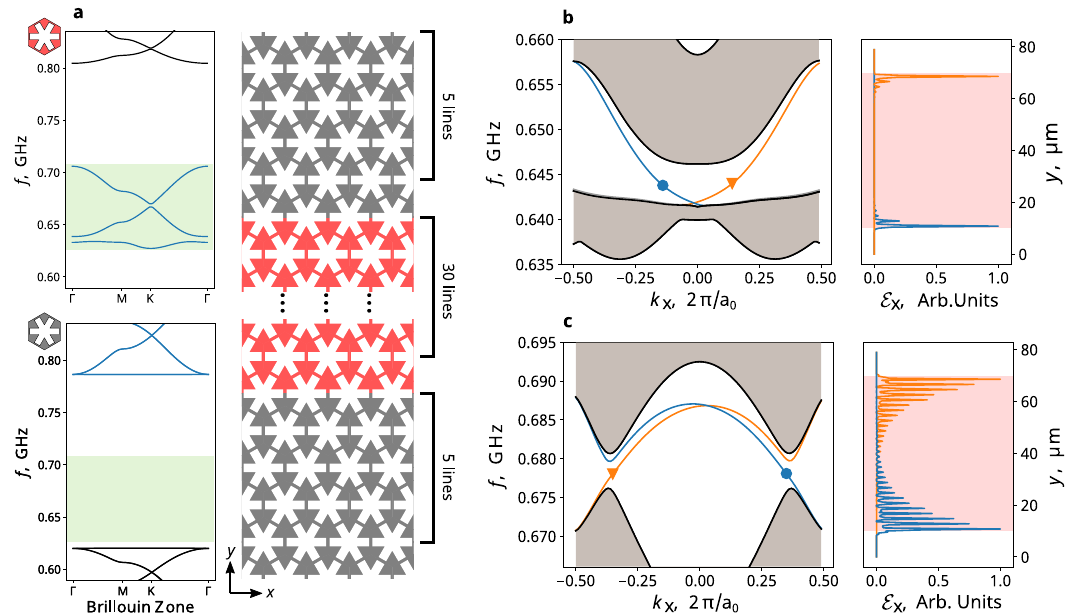
Fig. 2 | Magnet-free passive phononic Chern insulator and chiral edge states. a Thesupercellsetupforedgestatecalculation.Left:thebandstructuresofthered and black phononic crystal unit cells. The red unit cell consists of PZM materials withpositivedopingcharges,andtheblackunitcellconsistsofdielectricmaterials with Young ’ s modulus of 36.5GPa, featuring a trivial gap within the frequency of interest shaded in green. Right: schematicdrawing ofthe supercell,whichconsists